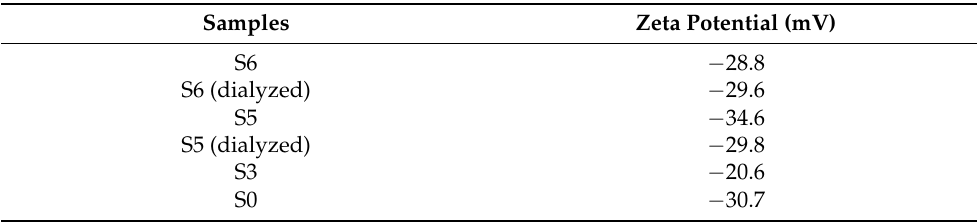
Table 2. Mean zeta potential values for all analyzed samples.